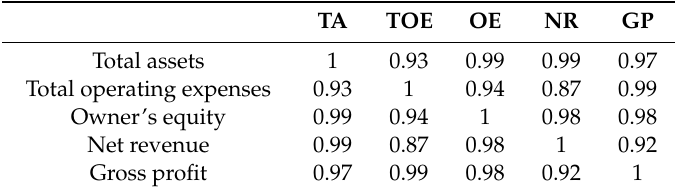
Table 6. Correlation matrix (Thailand-2019).